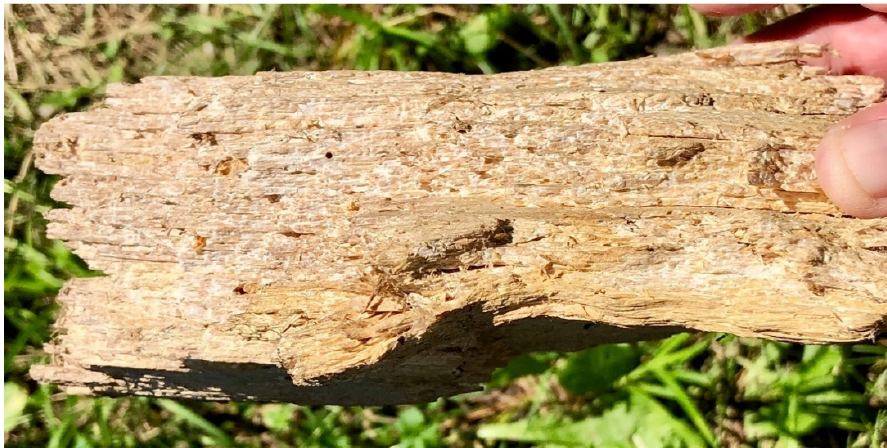
Figure 2. Advanced stage of white rot simultaneous decay. The wood in this advanced state of decay can be quite spongy and lightweight when dried. However, when decay is active, the wood will be moist and stands of wood can often be peeled from the surface along the grain. The flecks of white in the image are mycelial mats of the